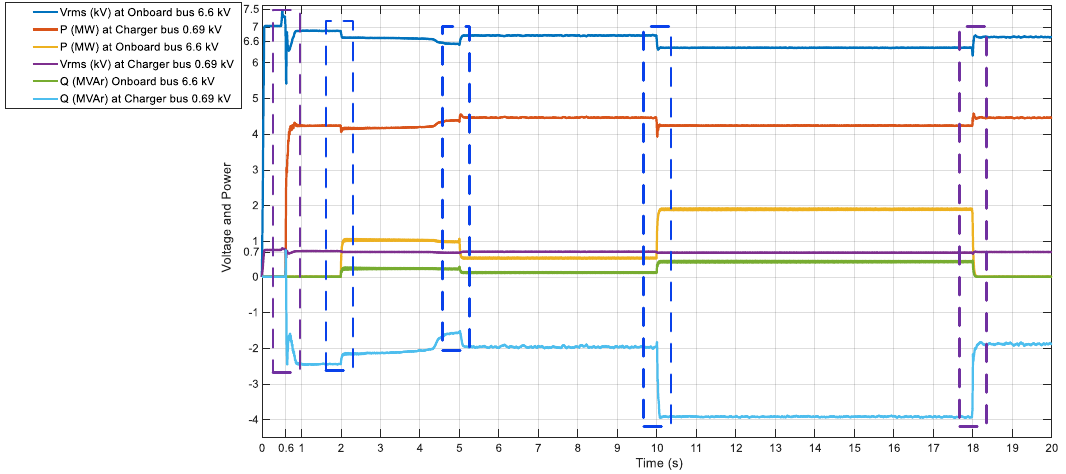
Figure 8. Voltage and power at onboard and charger buses in configuration D.